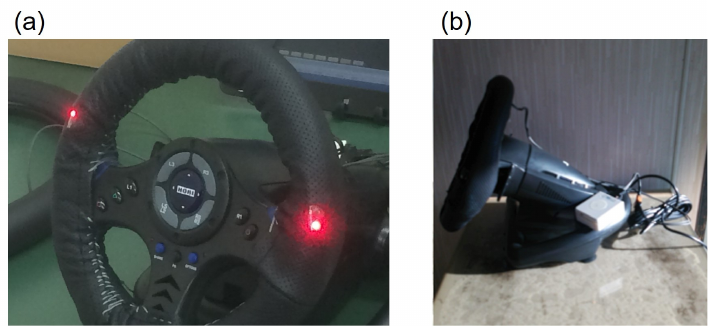
Figure 2. Steering-type blood pressure monitoring system by Arakawa et al.: ( a ) front view of the system and ( b ) side-on view of the system from the right.